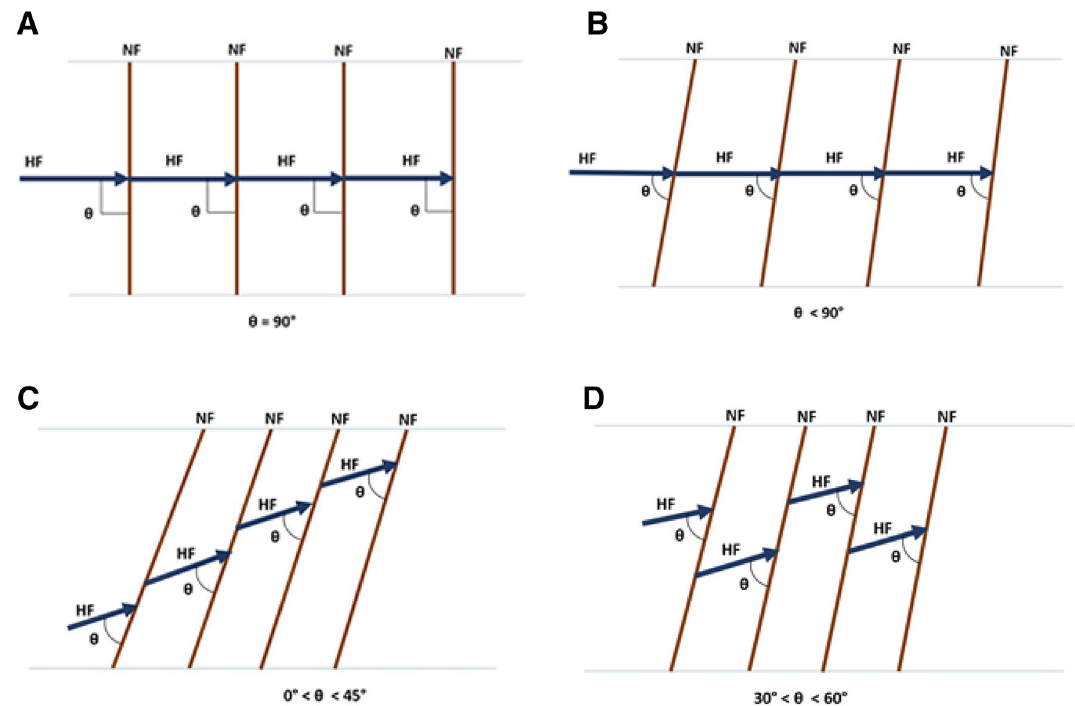
Fig. 4 Fracture networks created due to HF–NF Interactions featuring array length of 4; a orthogonal fracture network, b sub-orthogonal frac- ture network, c linear-to-sublinear fracture network (unidirectional stepping), d linear-to-sublinear fracture network (bidirectional stepping)